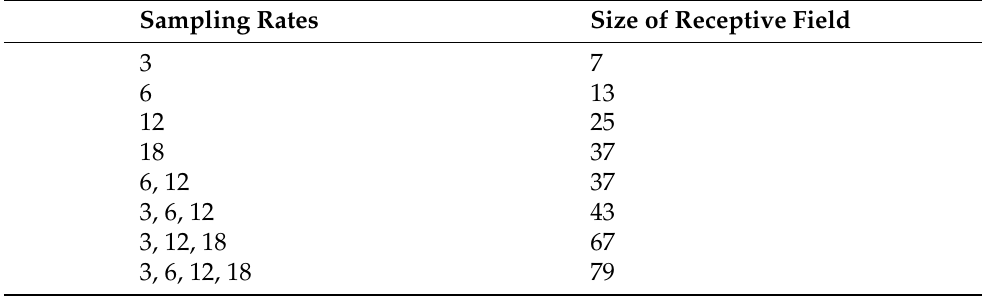
Table 2. Different combinations of sampling